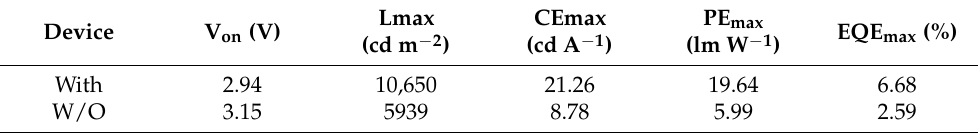
Table 1. Device performances of PeLEDs with and without TFB